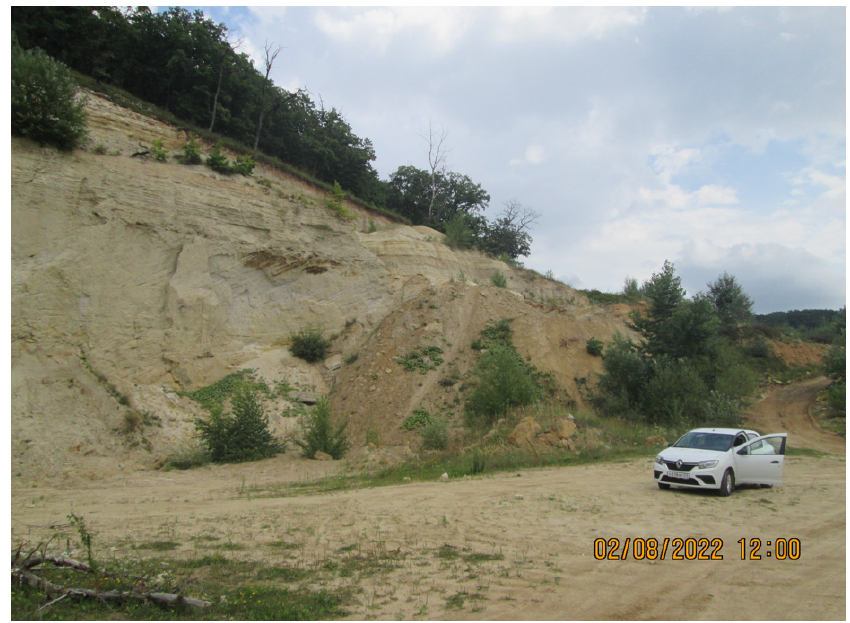
Figure 7. The lower part of the Shakhan geoheritage point, with an unpaved road leading to it from Kamennomostsky (the road is visible on the right).